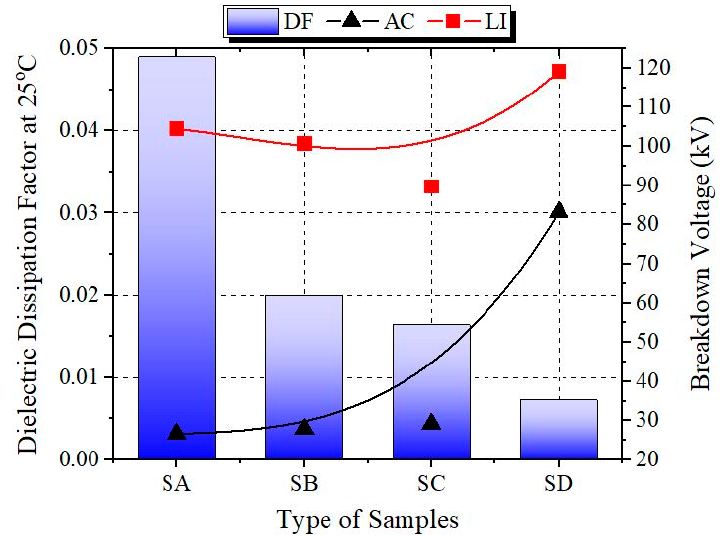
Figure 16. Influence dissipation factor of oil samples towards AC breakdown voltage and lightning impulse measurement at an ambient temperature.